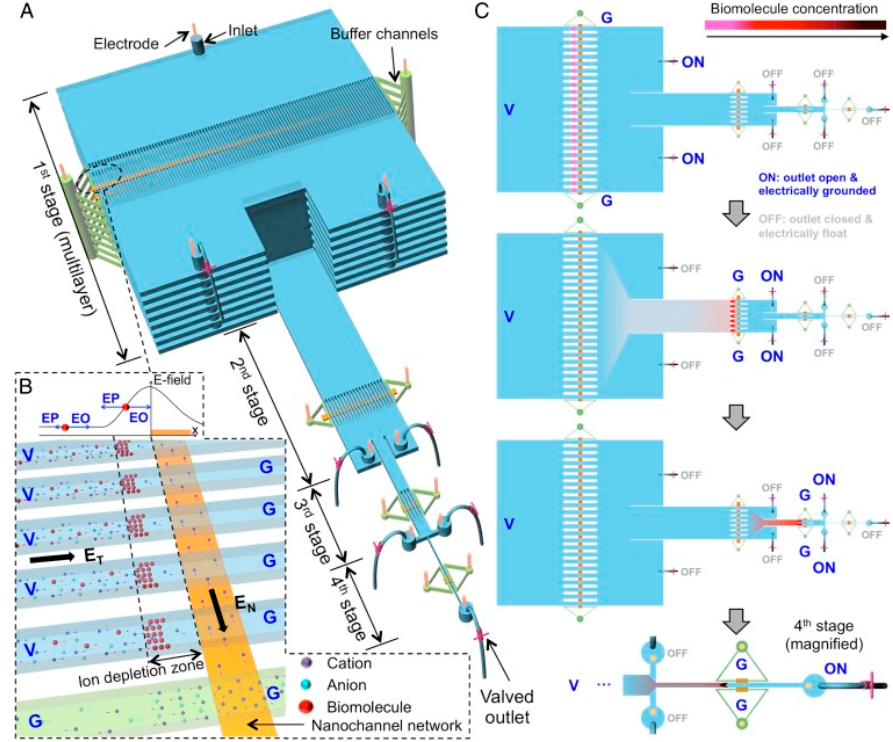
Figure 4. Principle of HOLMES. ( A ) Schematic of HOLMES with hierarchical multistages. At each stage, parallel microchannels and buffer channels are bridged by a thin nanochannel network patterned on the bottom of the microchannels. ( B ) Schematic of nanofluidic biomolecule concentration in massively parallel channels. Under the electrical configuration shown, biomolecules are electro- osmotically injected into the parallel channels and electrokinetically concentrated in the ion depletion zones induced near the micro-nanochannel junctions. ( C ) Schematic of relayed reconcentration of biomolecules from massively parallel microchannels into a single microchannel to dramatically boost the concentration performance. Reprinted with permission from ref. [105]. Table 1. A comparison of microfluidic HIV